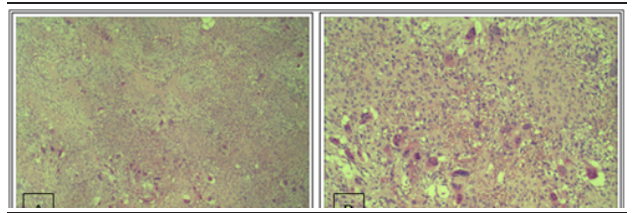
FIGURA 5 – Exame microscópico do tumor de antro maxilar